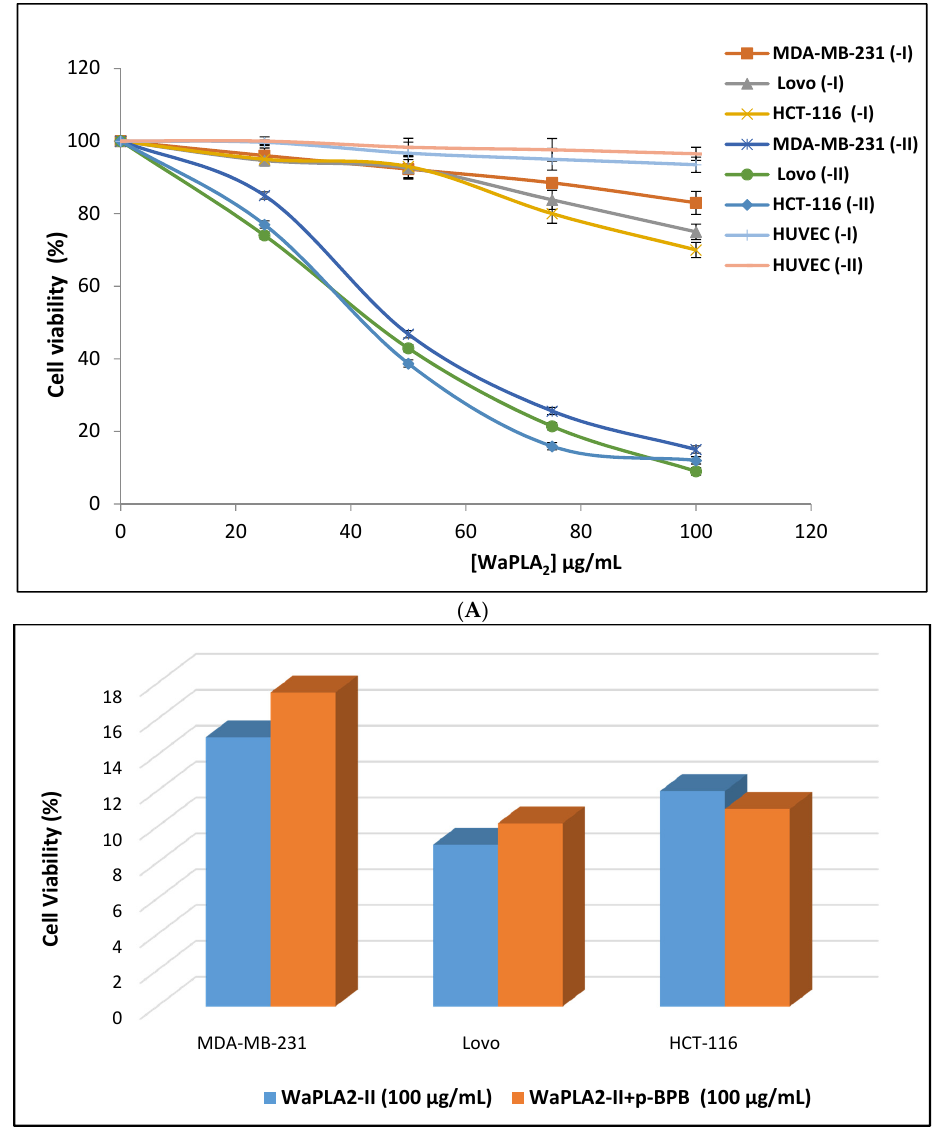
Figure 8. Cytotoxic effect of Wa PLA 2 -II and -I on LoVo, HCT-116, and MDA-MB-231 cells. To determine the cell viability, cells were maintained in culture for 24 h with [0–100 μ g/mL] concentrations of both enzymes using MTT solution. Cytotoxicity was assessed using the MTT assay by incubating cells for 24 h with various concentrations (25, 50, 75, and 100 μ g) of each enzyme ( A ) or with Wa PLA 2 -II (100 μ g/mL) with or without p-BPB ( B ). Triton X-100 (0.1%) in the assay medium and the assay medium alone served as positive and negative controls, respectively. The results represent the means of three independent experiments. Cell viability was calculated as the mean ± SD (n = 3).